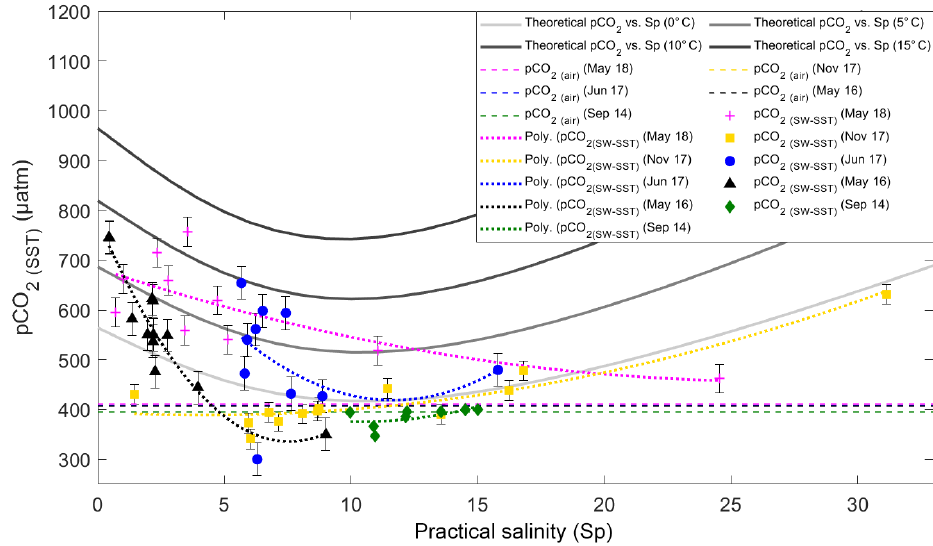
Figure 8. Temperature-normalized field p CO 2(SW-SST) and results of the conservative, two end-member mixing model for p CO 2(SW-SST) in the Saguenay Fjord surface waters. p CO 2(SW-calc) was normalized at each station to the average surface water temperature per sampling month (i.e., T = 10 . 4 ◦ C for September 2014; T = 5 . 04 ◦ C for May 2016; T = 11 . 9 ◦ C for June 2017; T = 7 . 13 ◦ C for November 2017; and T = 5 . 08 ◦ C for May 2018) to account for the effects of temperature on the CO 2 solubility in water, following the procedure described in Jiang et al. (2008). Dashed lines represent the p CO 2 ( air ) in the sampling months (396ppm in September 2014, 407ppm in May 2016, 408ppm in June and November 2017, and 411ppm in May 2018). Error bars show standard error of the mean for p CO 2(SW-SST) values – bars are smaller than the symbol for September 2014.